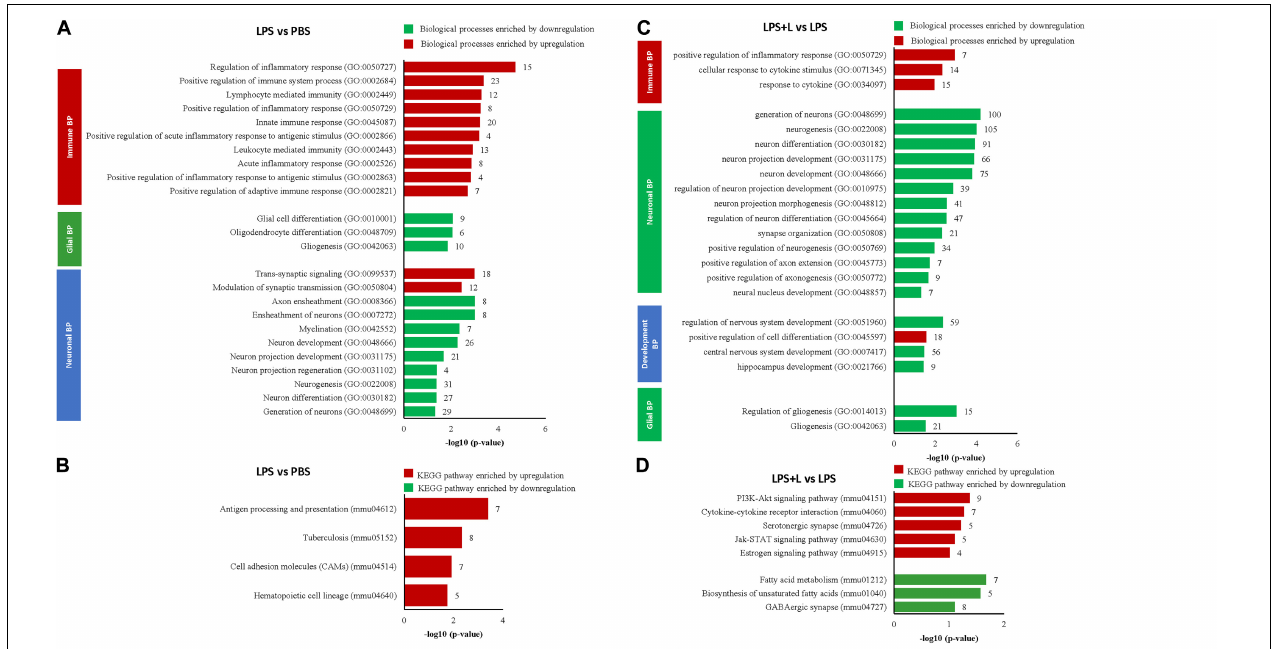
FIGURE 5 | Luteolin treatment significantly regulated gene expression in hippocampus of LPS-induced depression mice model. (A,B) Differentially regulated biological processes (BP) and top significantly enriched KEGG signaling pathways in hippocampus of LPS-induced depression mice (LPS) compared to untreated mice (PBS). (C,D) Differentially regulated biological processes (BP) and top significantly enriched KEGG signaling pathways in hippocampus of LPS-induced depression mice treated with luteolin (LPS + L) compared to untreated LPS-induced depression mice